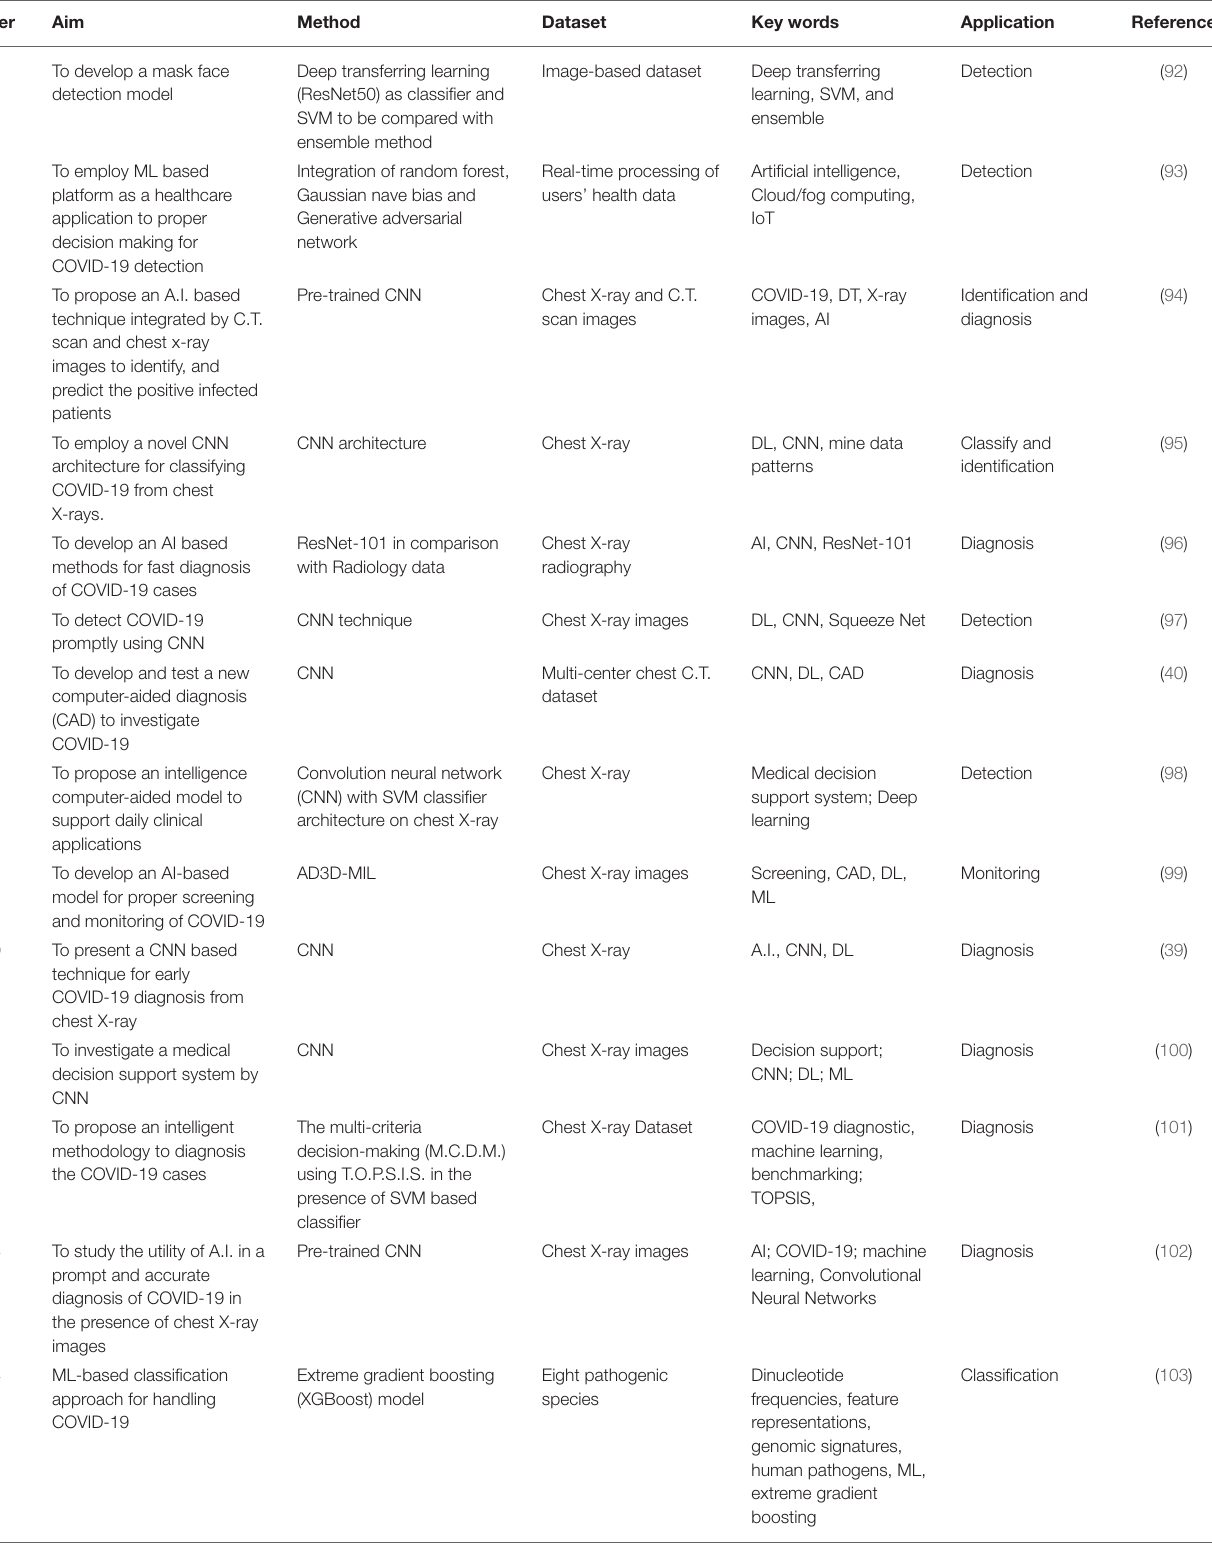
TABLE 4 | ML-based techniques for